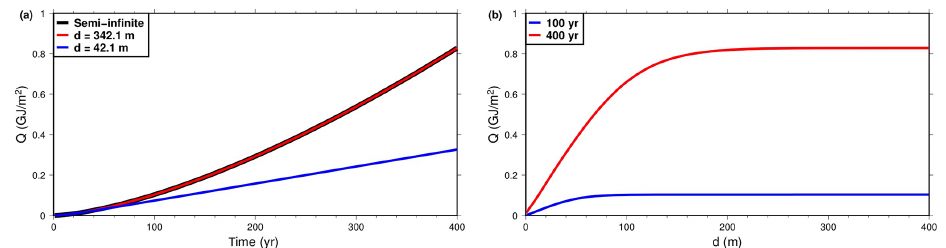
Figure 2. Heat absorbed by the land column per unit of area ( Q ), following the start of a linear surface temperature increase of 0.01Kyr − 1 . (a) Q as a function of time for the half-space model and two models of finite thicknesses (42.1 and 342.1m). (b) Q as a function of the thickness d of the finite model, at 100 years and 400